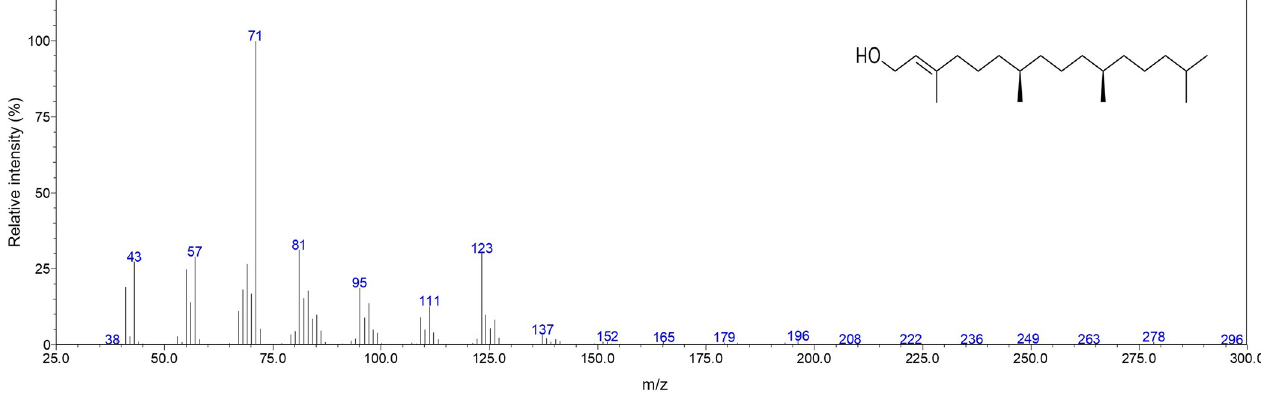
Fig 1. Mass spectra and chemical structure of phytol found in the present